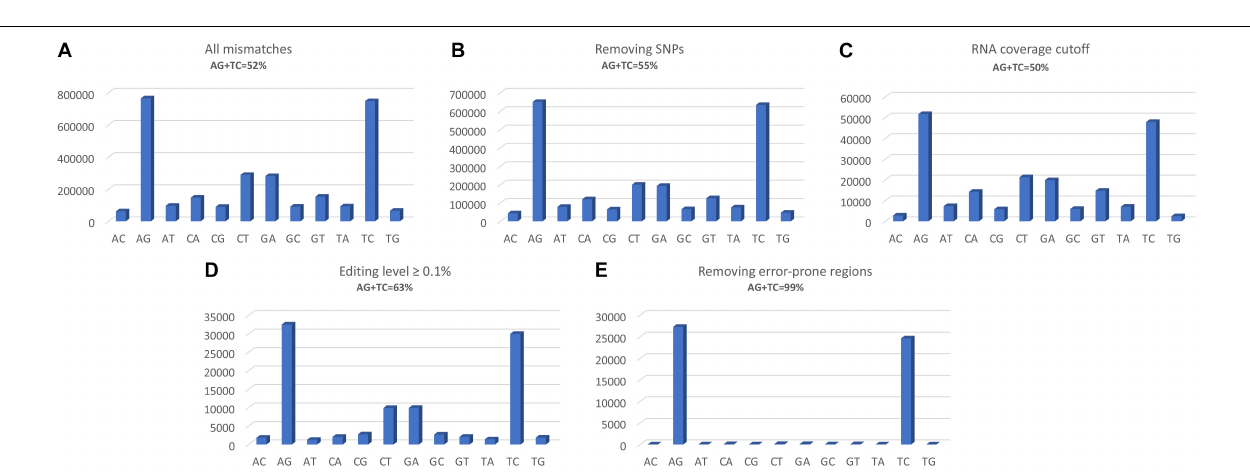
transcriptome sequencing has enabled large scale